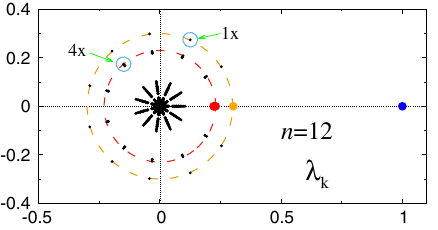
0 and n ¼ 12 . z ¼ [black dots on the 3 4 (orange point) and ð n − 6 Þ = 2 3 (the red point represents three almost 4